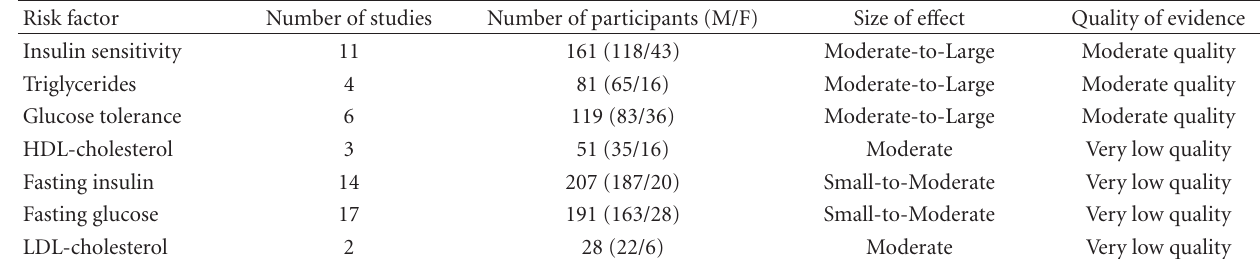
Table 2: Summary of key evidence.